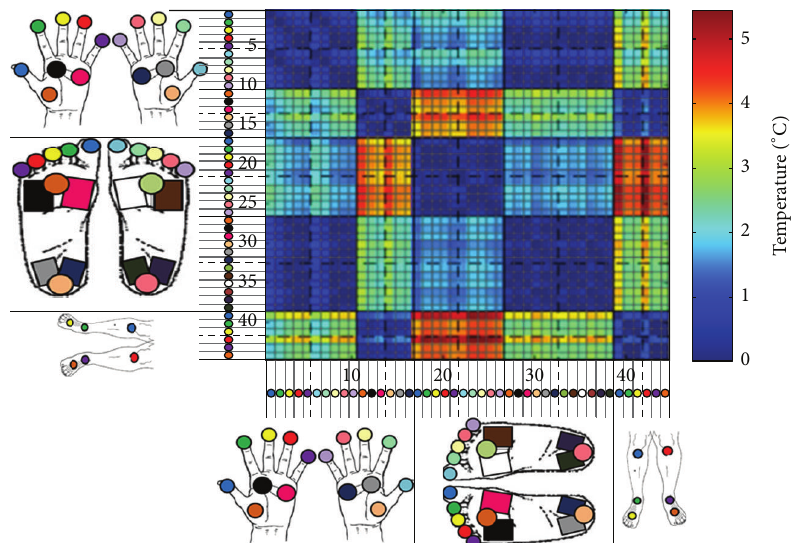
Figure 6: Matrix of the participant-averaged thermographic temperature mean differences between each region-pair.